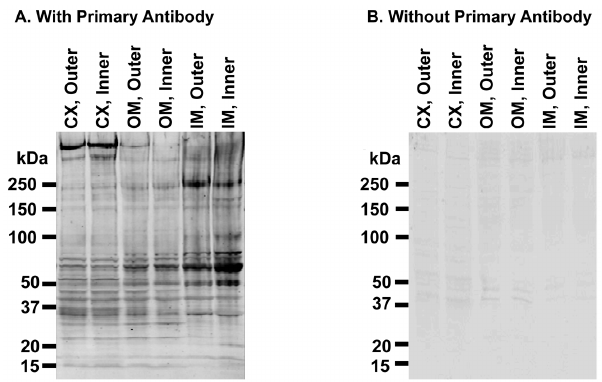
Figure 3. Immunoblots of rat kidney regions with and without the -anti-carbamyl-lysine antibody. A. Immunoblot of rat kidney regions using anti-carbamyl-lysine antibody. B. Control immunoblot of rat kidney regions without primary antibody. Rats were treated with two dDAVP injections (time 0 and 5 hours). 75 ug of protein were loaded onto gels. Abbreviations: CX, cortex; OM, outer medulla; IM,